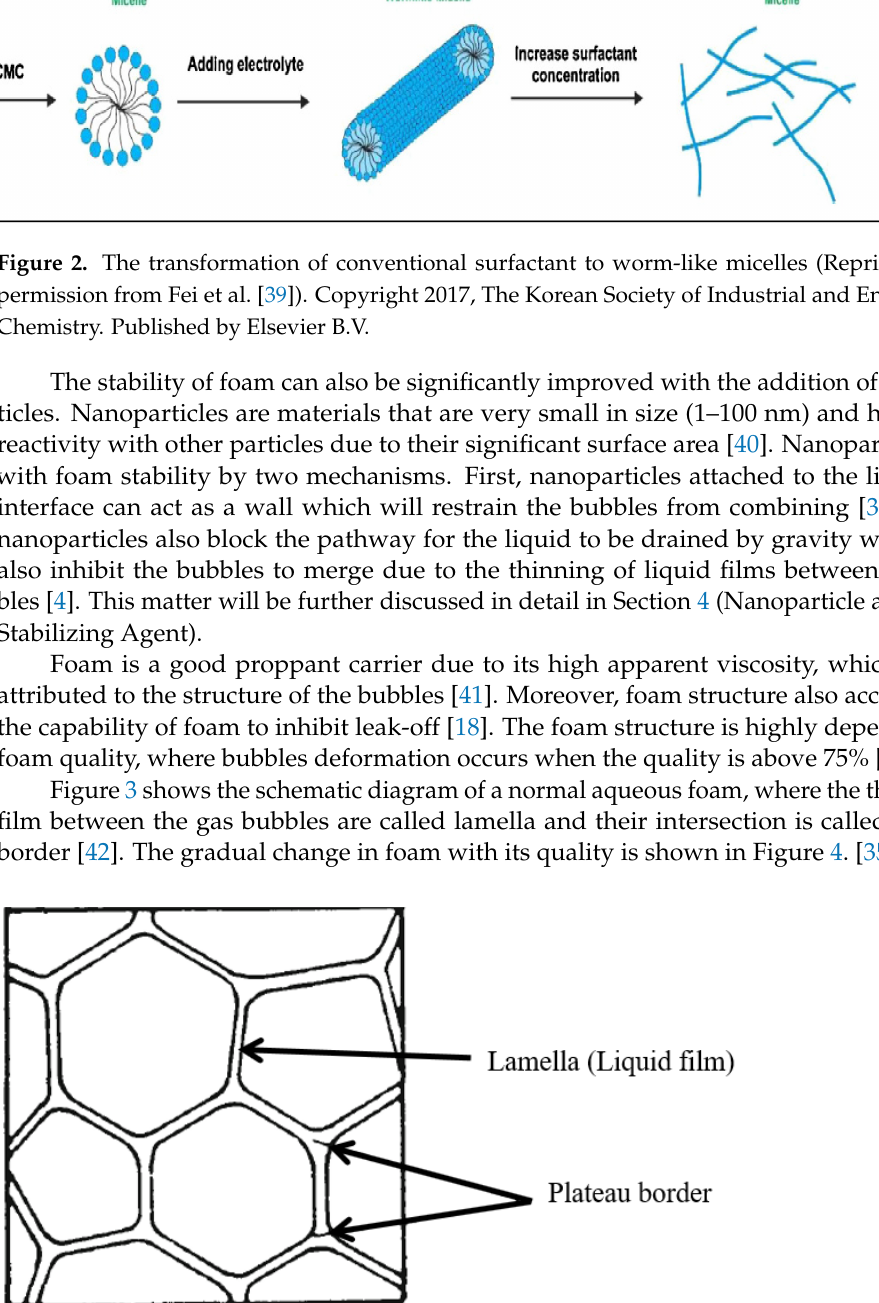
Figure 4. Difference of foam texture with quality (Davis et al. [35]). In a drainage process, the wet foam will get drier, and its shape will also change from spherical to polyhedral shapes due to the thinning of lamella [35]. Moreover, further drainage causes the lamella to rupture, which initiates the gas bubbles to combine, leading to bigger bubble sizes that destabilize the whole foam structure [42]. In short, understand- ing foam structure is essential in the knowledge of the foam rheology and stability. 1.2. Advantages and Limitations of Foam-Based Fracturing Fluids Although the water-based fluid is the most popular option for hydraulic fracture, the excessive use of water can negatively impact the environment due to the disposal of un- clean water after the flowback process [21]. Furthermore, water-based fluid may seriously affect water-sensitive formations with high clay content as it can induce swelling and leak into the reservoir [18]. Therefore, foam, a fracturing fluid that possesses minimal water volume and high gas content in such formations, is a more favorable option. Using high-